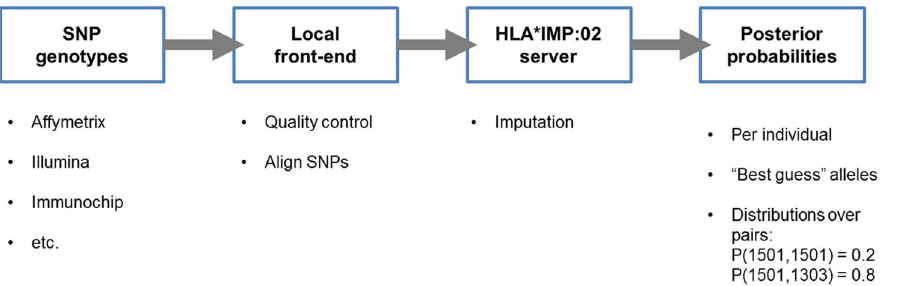
Figure 2. Standard workflow for HLA*IMP:02. Standard workflow for HLA*IMP:02: standard output data from popular genotyping platforms, for example current Illumina or Affymetrix chips, are converted into the HLA*IMP format using the locally installed front-end program. The front-end also carries out necessary steps of quality control, such as aligning SNP strandedness. The output files from the front-end are submitted to the HLA*IMP:02 server, which processes the data and produces imputations (posterior probabilities over pairs of alleles as well as a ‘‘best guess’’ pair of two alleles with associated quality scores).